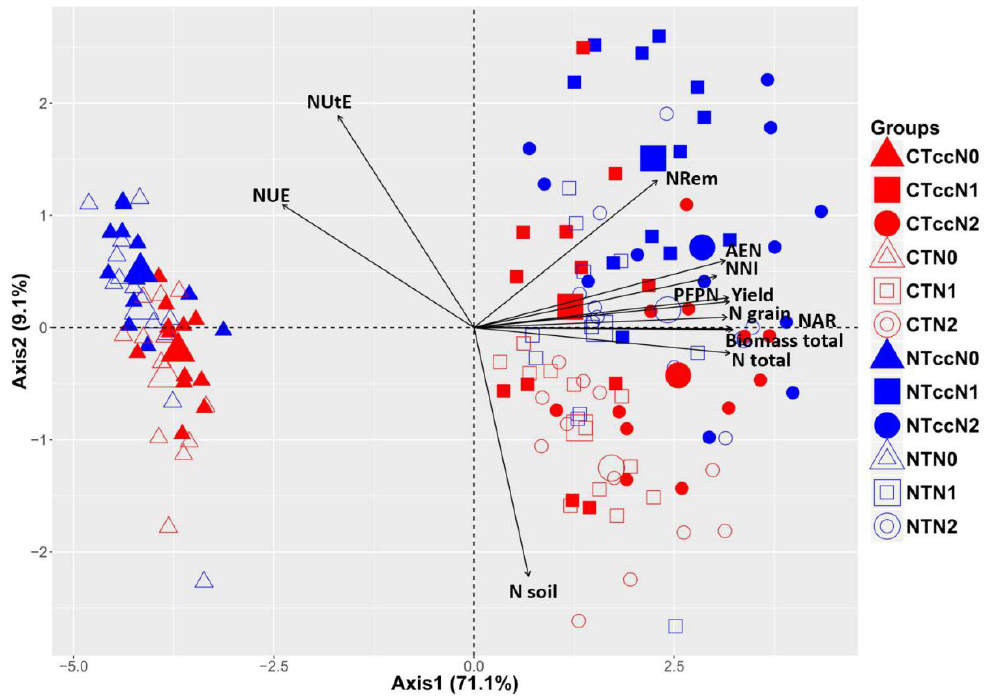
Figure 6. PCA analysis showing the correlations between agronomic traits and NUE traits according to the tillage conditions, the presence of cover crops and the level of N fertilization over two years. Diagrams are defined by the first two axes of the PCA of the different variables ( n = 12); Axis1 (71.1% of variance explained) and Axis2 (9.1% of variance explained). NTcc: No till with cover crops. NT: No till without cover crops. CTcc: Conventional tillage with cover crops. CT: Conventional tillage without cover crops. N0: no added fertilization. N1: 161 kg N ha −1 . N2: 215 kg N ha −1 .